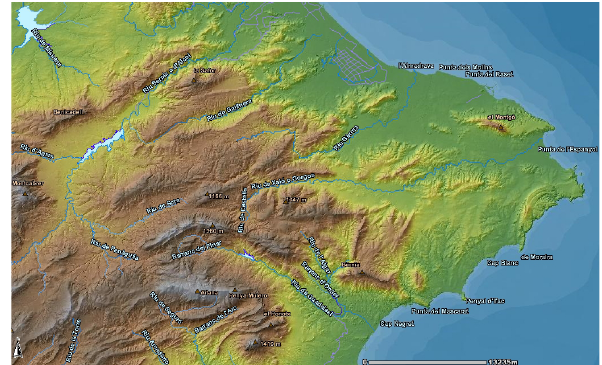
Fig. 2. Northern Alicante province orography. Courtesy of Consel- leria de Medi Ambient, Aigua, Urbanisme i Habitatge de la Gener- alitat